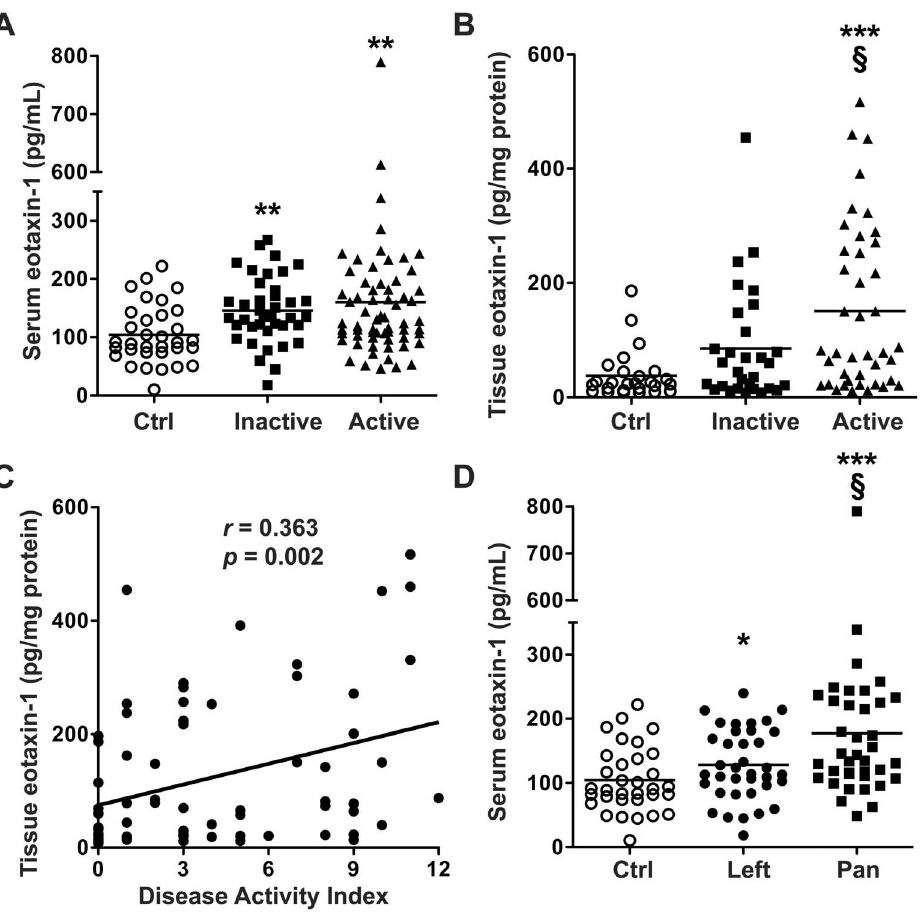
Figure 5. Serum and tissue cytokine/chemokine levels based on indices of disease severity. (A – B) Active disease is defined as a DAI . 2, inactive disease as DAI 0 or 1. In A and B, for serum, n =34 for control, and n =103 for UC; for tissue, n =34 for control, and n =72 for UC. ** p , 0.01; *** p , 0.001 vs. control. 1 p , 0.05 vs. inactive disease. (C) Tissue eotaxin-1 is correlated with the DAI. In C, there are no data from control subjects undergoing colonoscopy for non-UC indications, as a DAI was not obtained in control subjects. (D) Serum eotaxin-1 is significantly increased in pancolitis patients vs. left sided-colitis patients. In D, n =34 for control, n =37 for left-sided colitis, and n =38 for pancolitis. * p , 0.05 ; *** p , 0.001 vs. control. 1 p , 0.05 vs. left-sided colitis. In A and D, the control samples are the same.